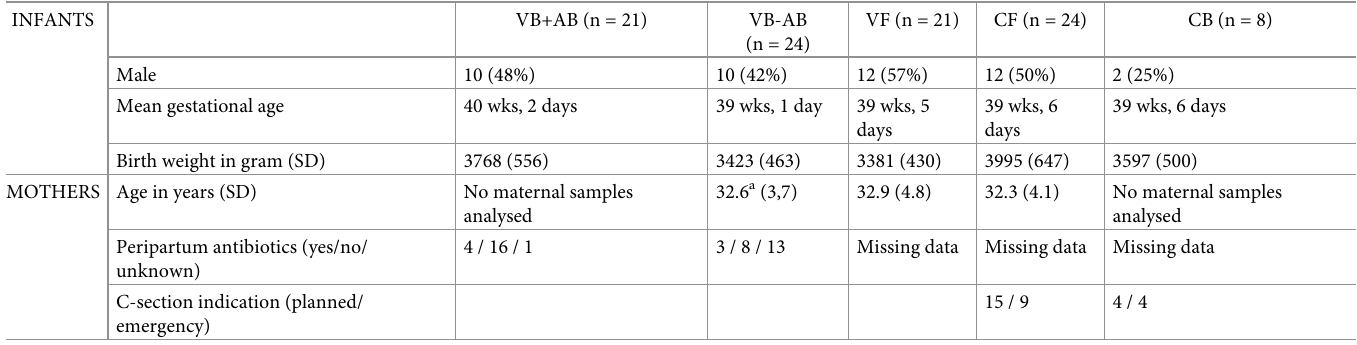
Table 1. Study cohort